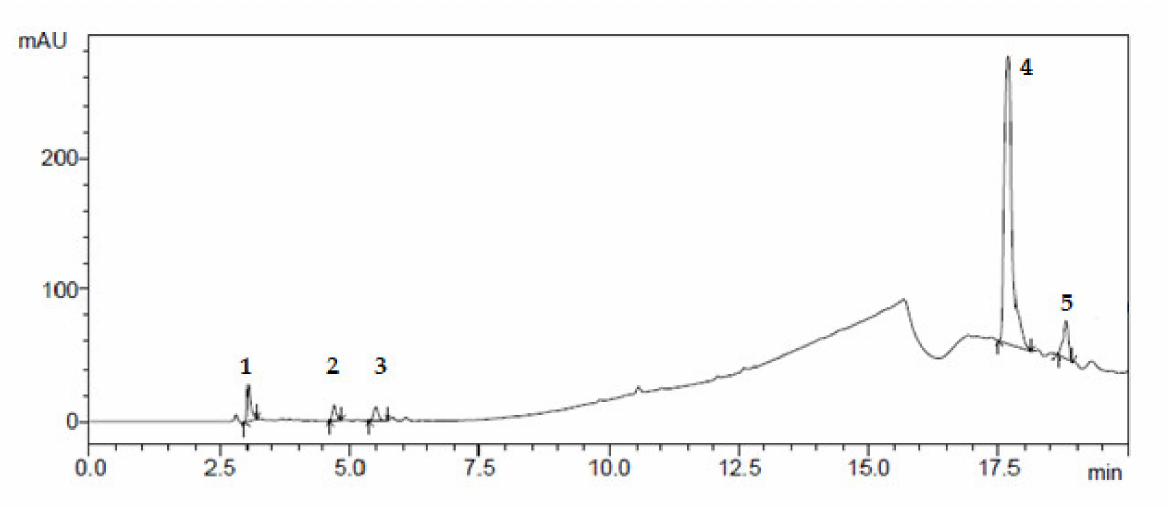
Figure 1. Preparative isolation of BAS from Dactylorhiza maculata extract samples: (1) rutin; (2) hyperoside; (3) ferulic acid.